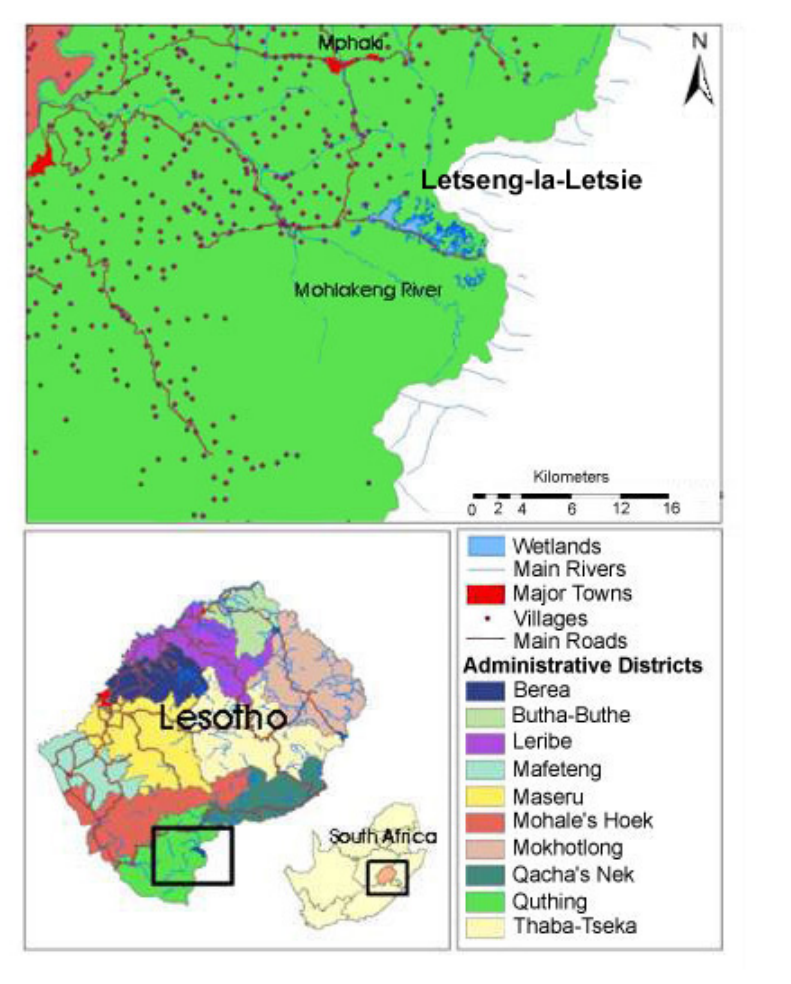
Fig. 1 . Location of the Letseng-la-Letsie wetland in